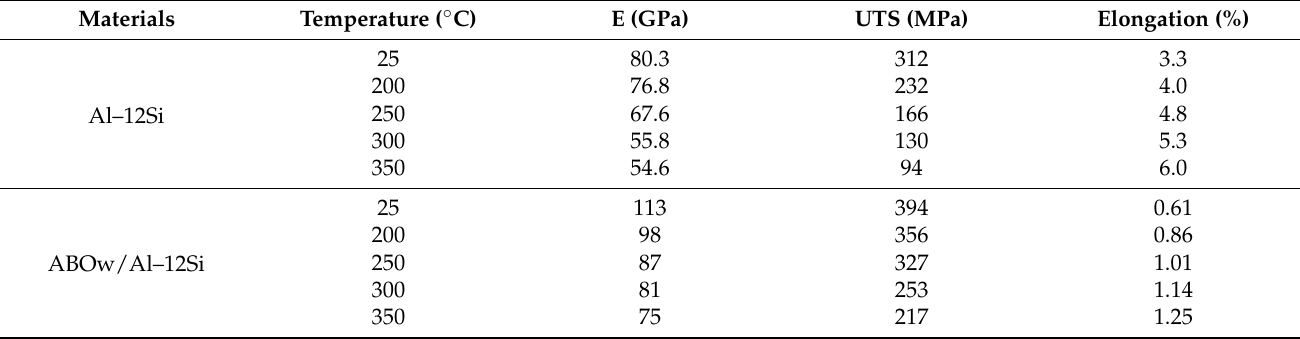
Table 2. Tensile properties of the ABOw/Al–12Si composite and the Al–12Si alloy at different temperatures.